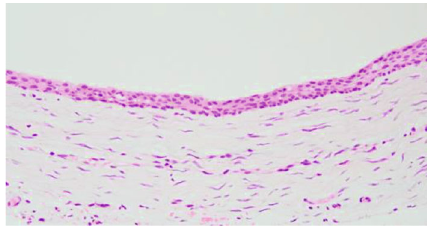
Figure 2: Photomicrograph of the dentigerous cyst. The cystic wall, which is covered by fl at squamous cell epithelium, is composed of fi brous connective tissue with scarce in fl ammatory in fi ltrate (H-E staining, original magni fi cation × 20).